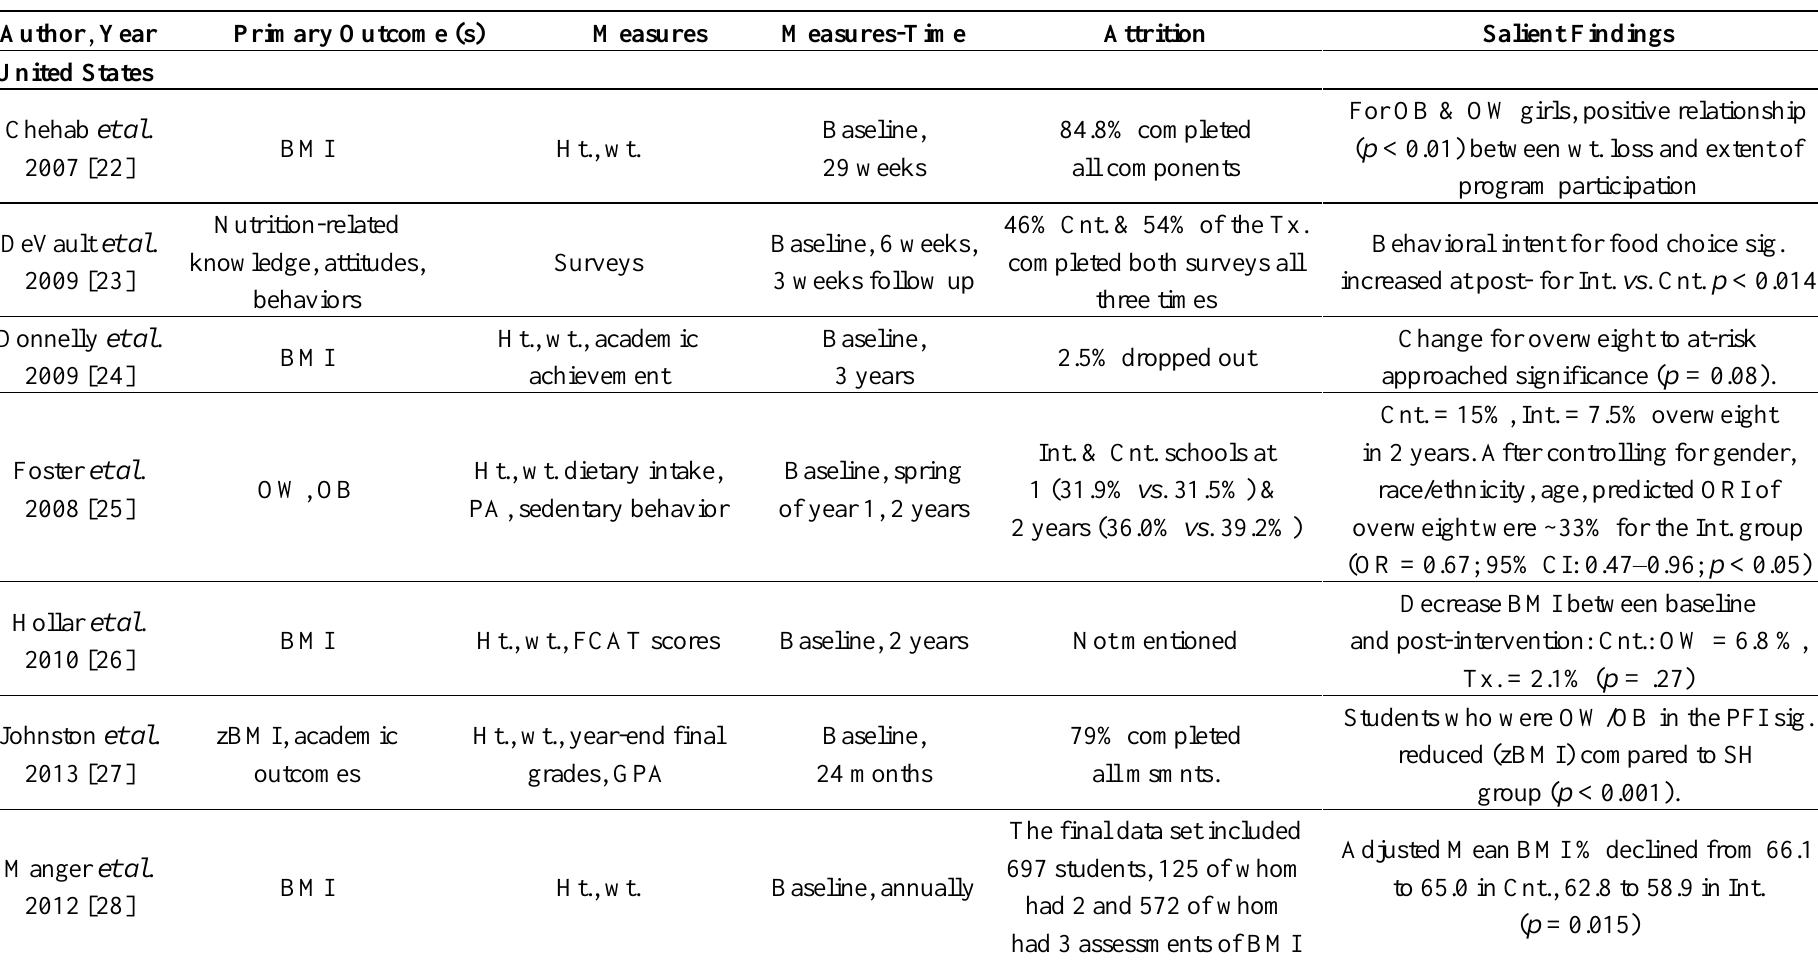
Table 2. Summary of interventions—outcomes, measures, salient